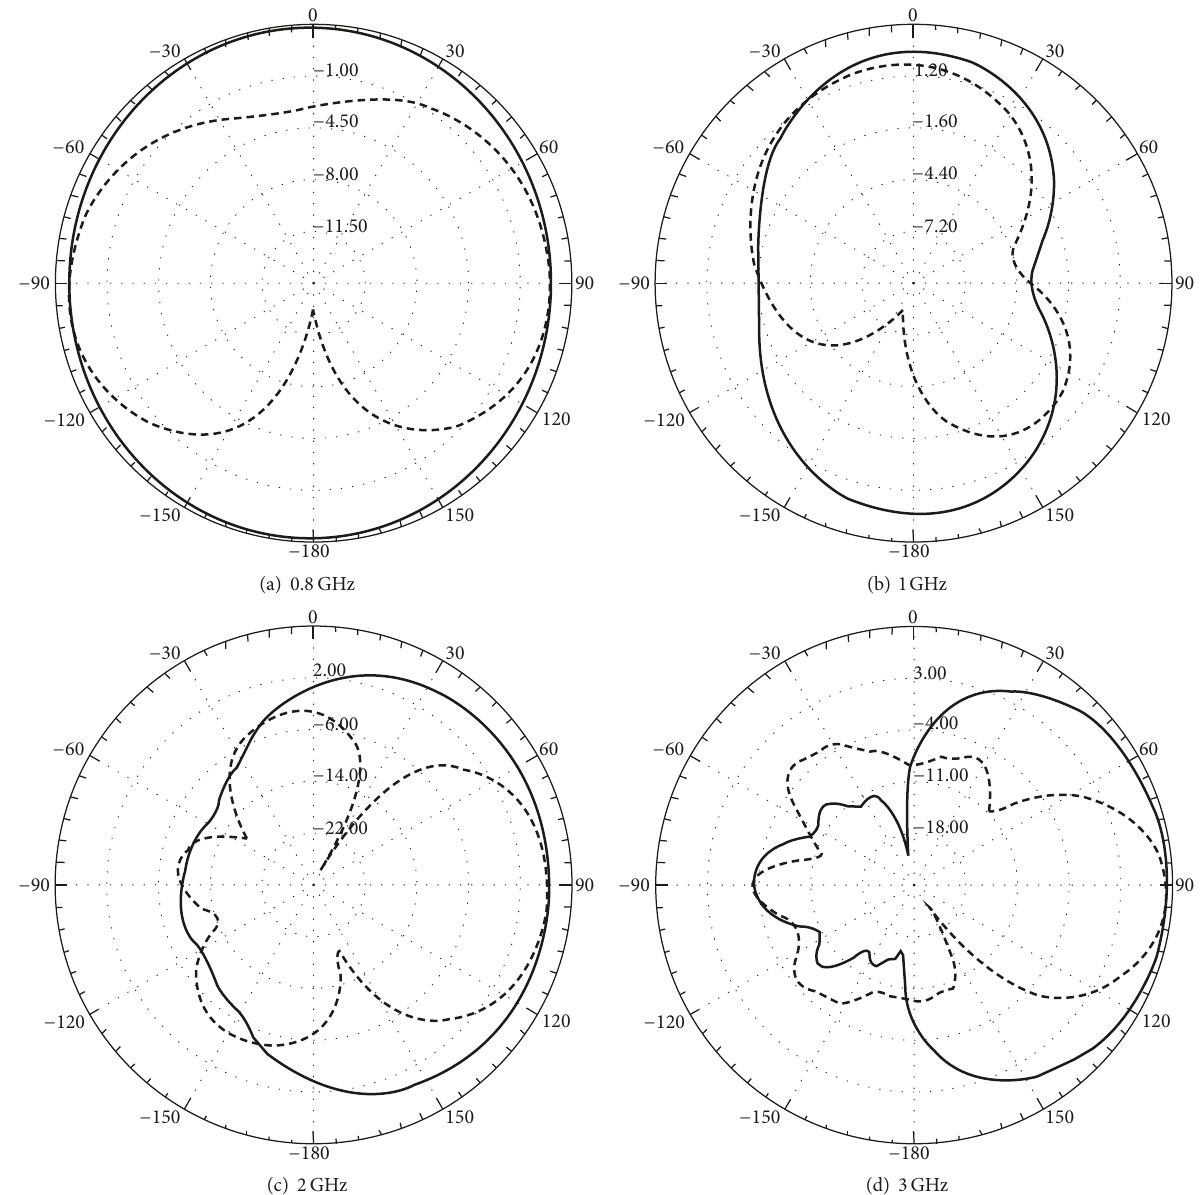
Figure 11: Radiation pattern of the antipodal Vivaldi antenna at different